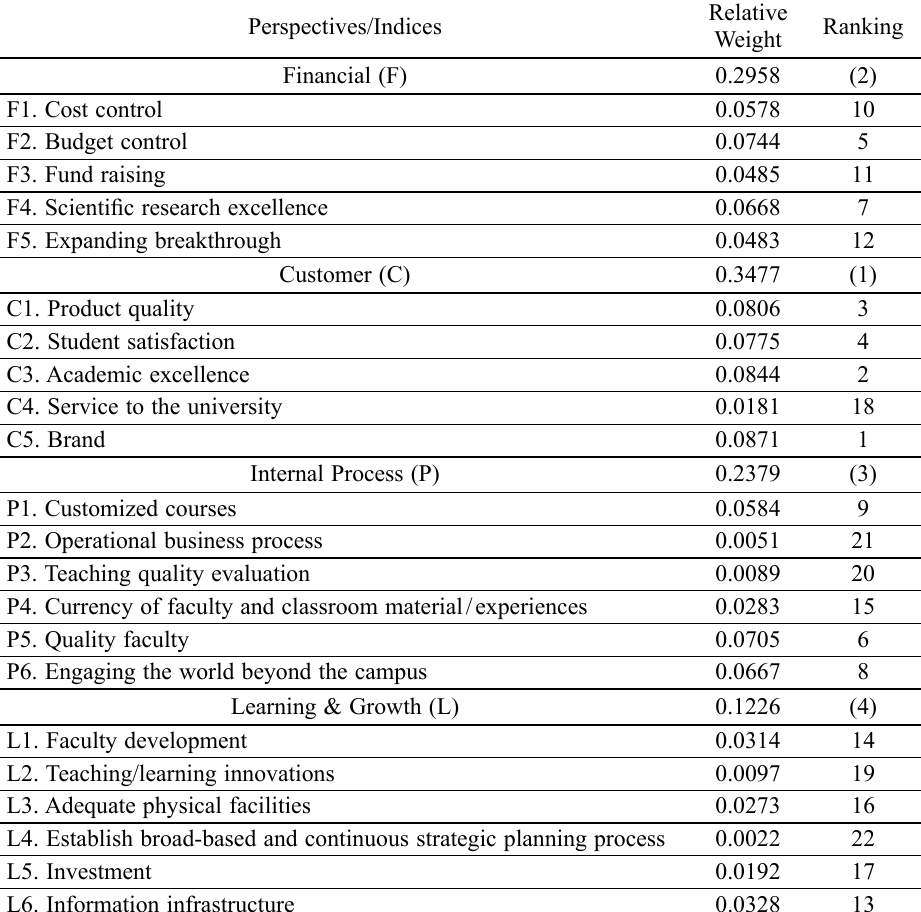
Table 8. Relative weights of performance